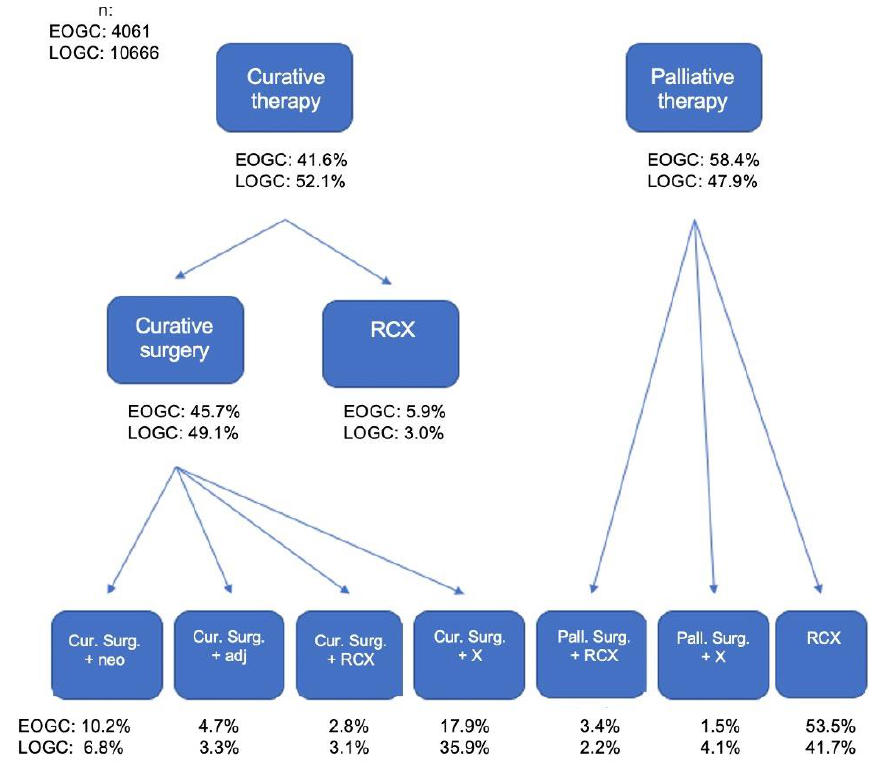
Figure 3. Treatment algorithms in both groups EOGC and LOGC.